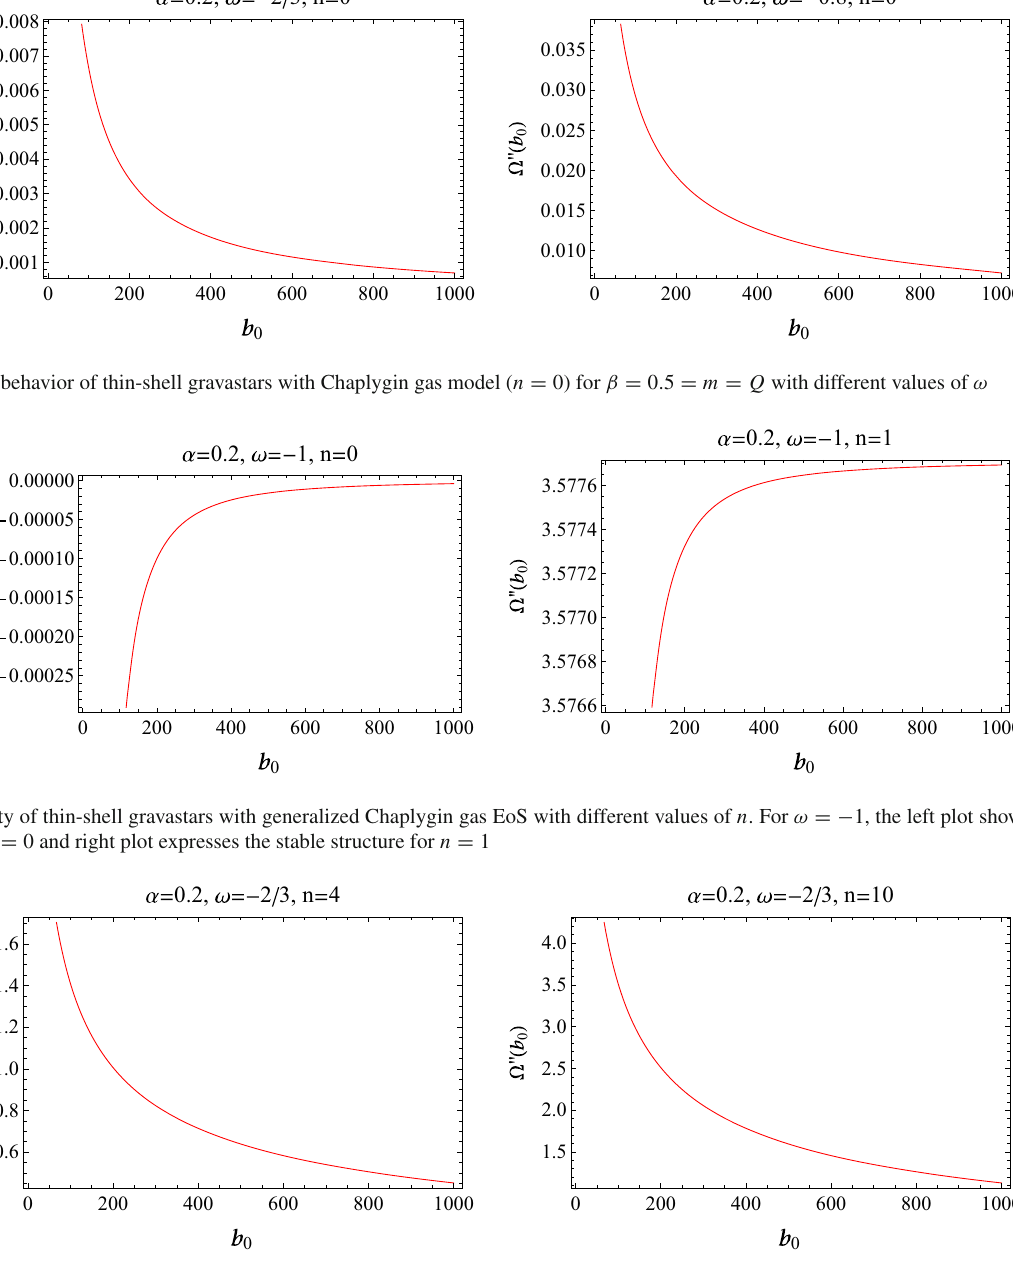
Fig. 5 Stable behavior of thin-shell gravastars for different values of n . The stability of developed structure is enhanced for large values of